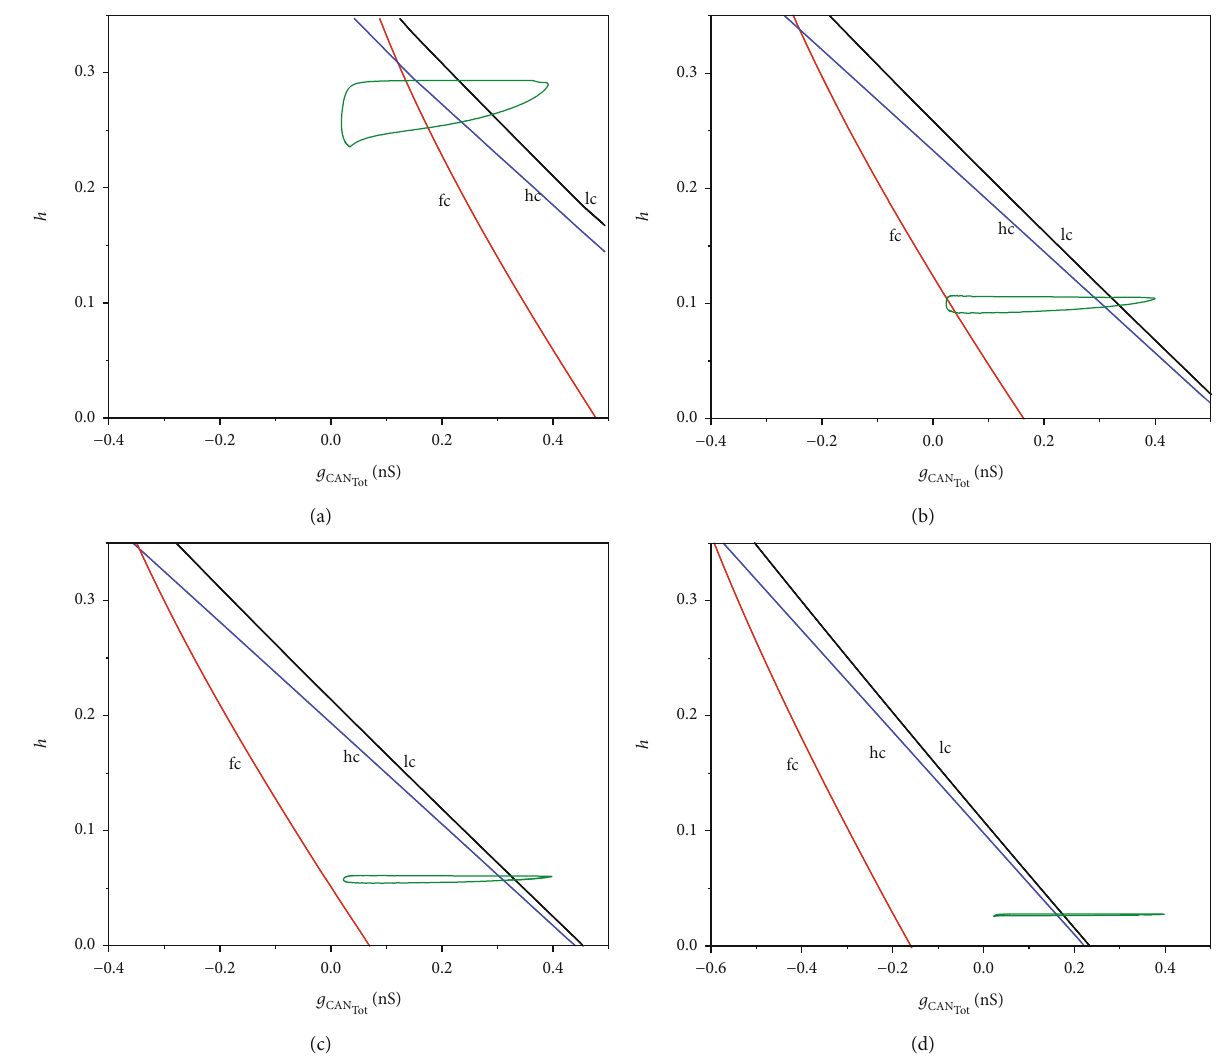
Figure 11: Two-parameter bifurcation diagram with the e ff ect of magnetic fl ow on ( g (d) k = 1 : 5 1